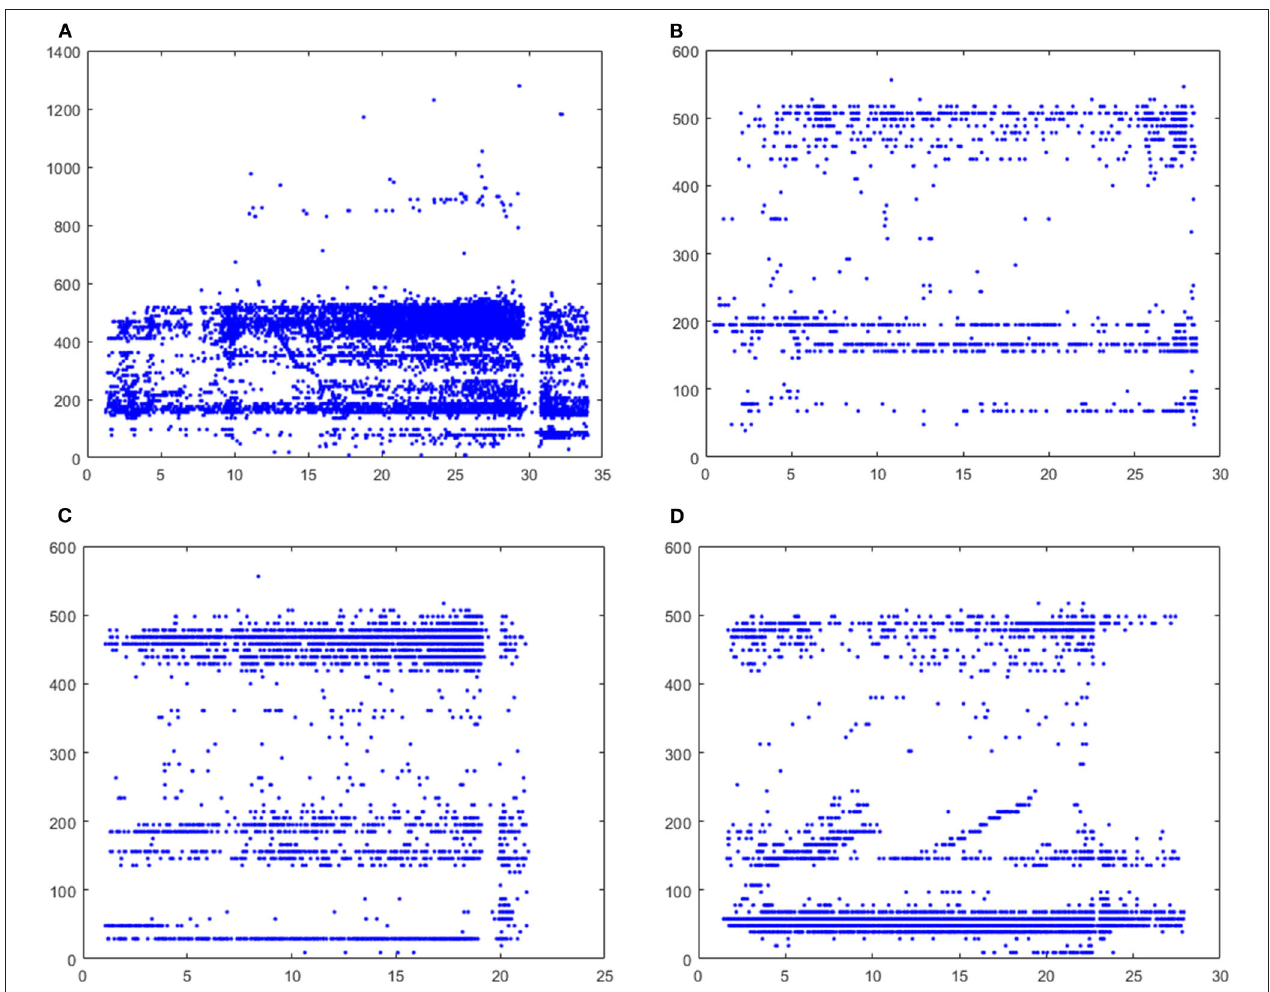
FIGURE 4 | Peak frequency distribution with loading time. (A) is the peak frequency distribution and corresponding density contours of granite; (B) is the peak frequency distribution and corresponding density contours of limestone; (C) is the peak frequency distribution and corresponding density contours of the peak frequency distribution with loading time of sandstone; (D) is the peak frequency distribution and corresponding density contours of the peak frequency distribution with loading time of